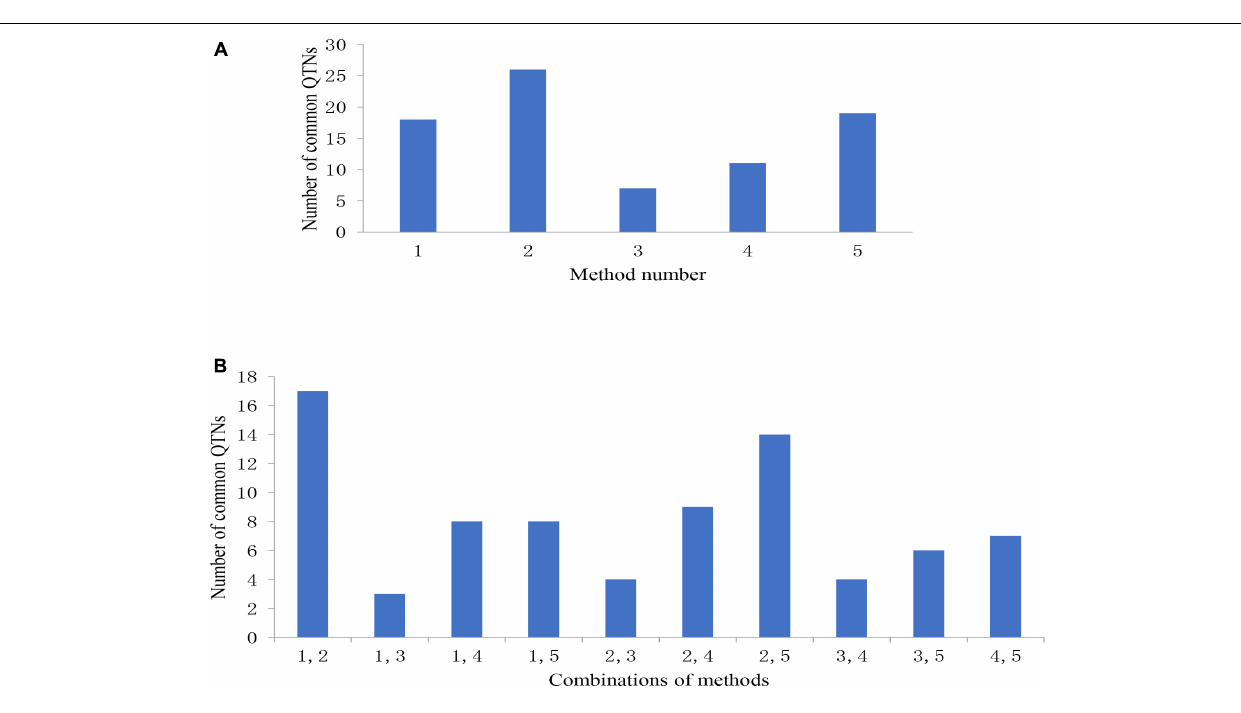
HSW is not only affected by genotype and environmental factors, but also by genotype-by-environmental interaction effects. The heritability of HSW in multiple environments